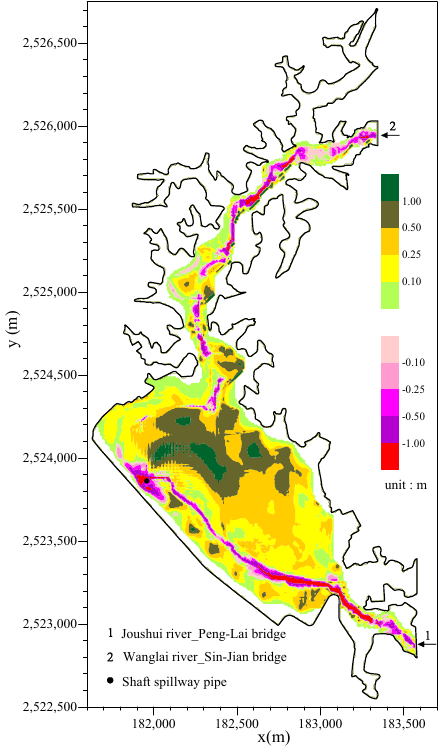
Figure 11. Bed evolution in the reservoir during a 50-year return period, t = 120 h.